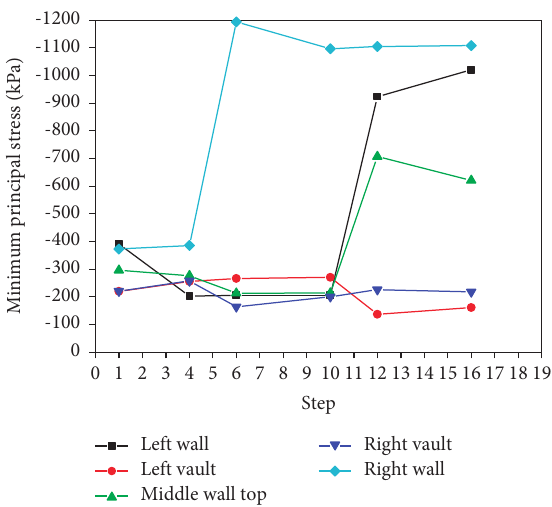
Figure 11: Minimum principal stress of scheme II. Figure 12: Minimum principal stress of scheme